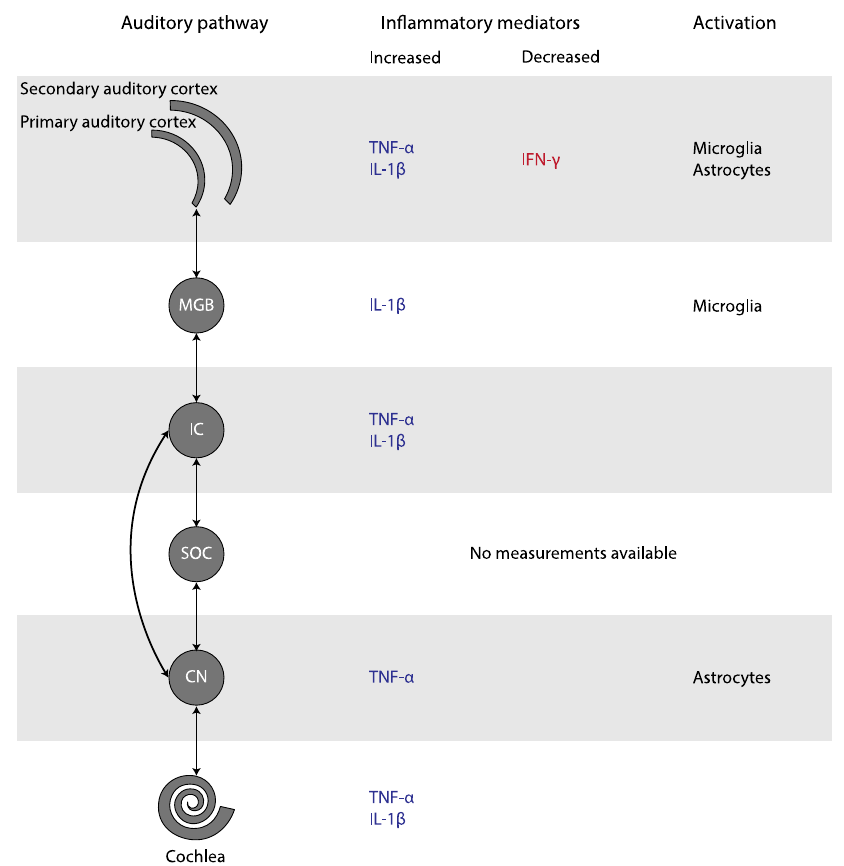
Figure 3. Changes in inflammatory mediators and glial activation in tinnitus, depicted in the simplified auditory pathway. Abbreviations: CN, cochlear nucleus; IC, inferior colliculus; IFN, interferon; IL, Interleukin; MGB, medial geniculate body; SOC, superior olivary complex; TNF, Tumor Necrosis Factor.